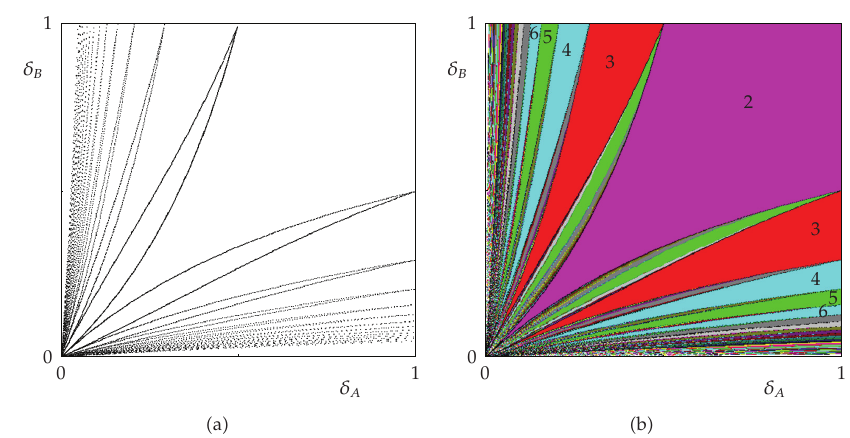
Figure 12: (cid:2) a (cid:3) For d (cid:7) 0 . 5, bifurcation curves of the principal tongues of period k , with k (cid:7) 2 ,..., 15 in the plane (cid:2) δ A ,δ B (cid:3) , δ A (cid:7) (cid:2) 1 − m L (cid:3) , δ B (cid:7) (cid:2) 1 − m R (cid:3) ; (cid:2) b (cid:3) corresponding bifurcation diagrams in the plane (cid:2) δ A ,δ B (cid:3) with colors obtained numerically according to the di ff erent periods